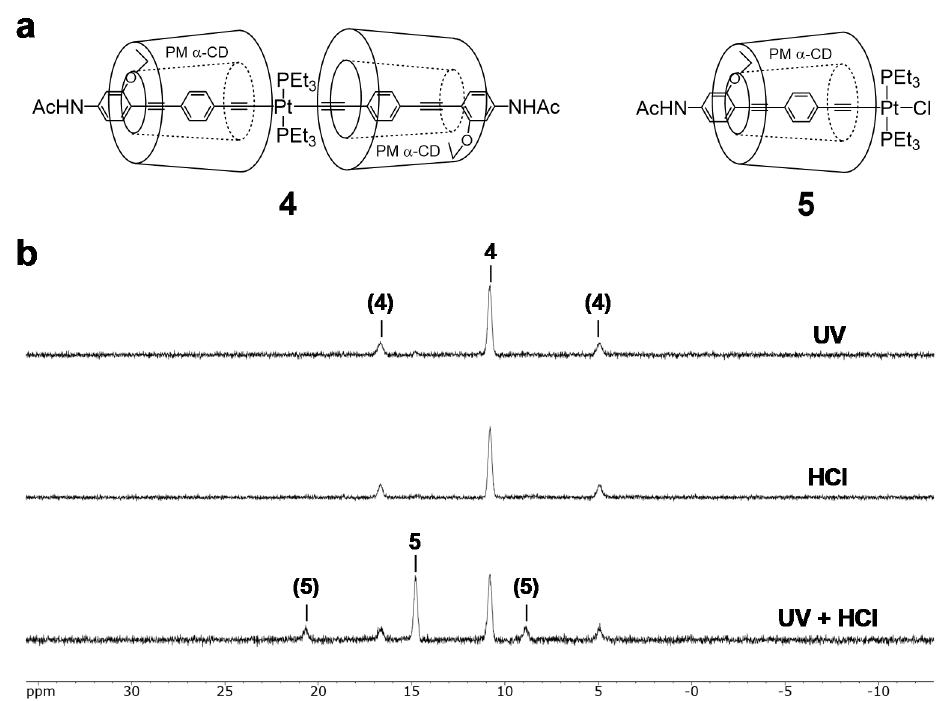
Figure 5. Light-induced acceleration of Pt-acetylide complex 4 : ( a ) Chemical structure of 4 and monochlorinated Pt complex 5 . ( b ) 31 P NMR (202 MHz, CDCl 3 ) analyses of 4 after reaction for 10 min under UV, HCl, and UV + HCl. Coupling peaks with platinum atom are in parentheses.